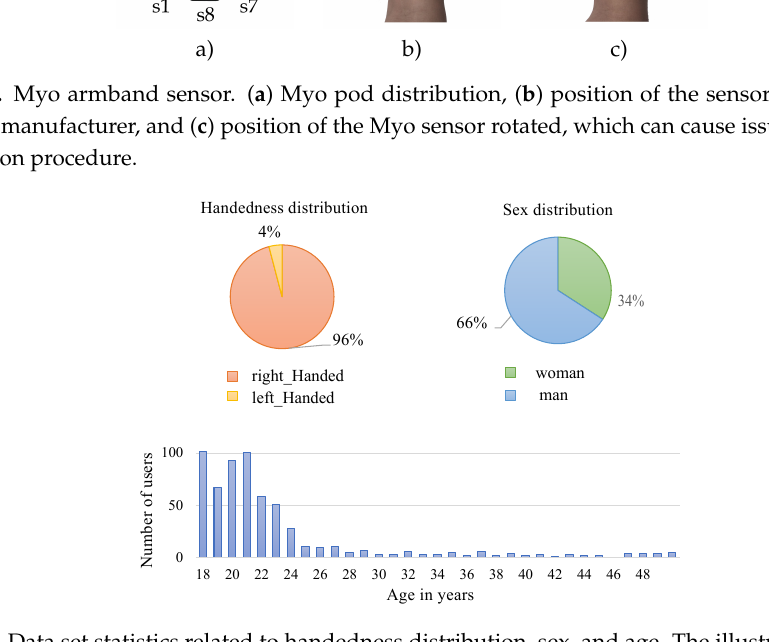
Figure 3. Data set statistics related to handedness distribution, sex, and age. The illustrations refer to the total number of users—612—in the data set. The data set is divided into 50% of users for training and 50% for test—306 for each, respectively.